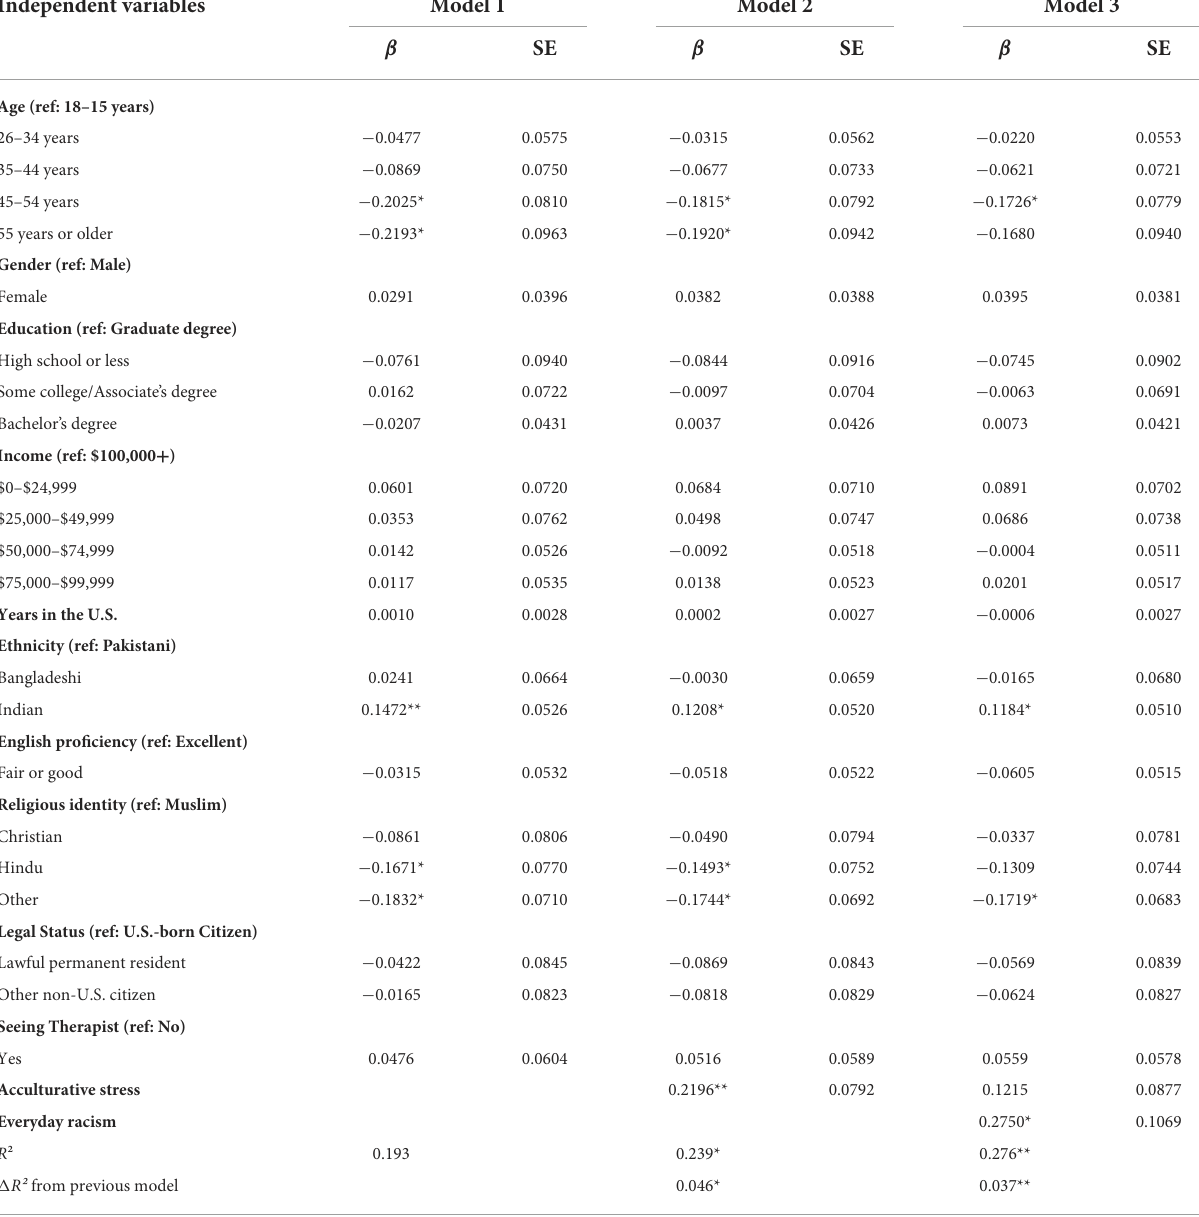
TABLE 2 Hierarchical multiple regression models predicting anxiety-related symptoms ( n = 200). Independent variables